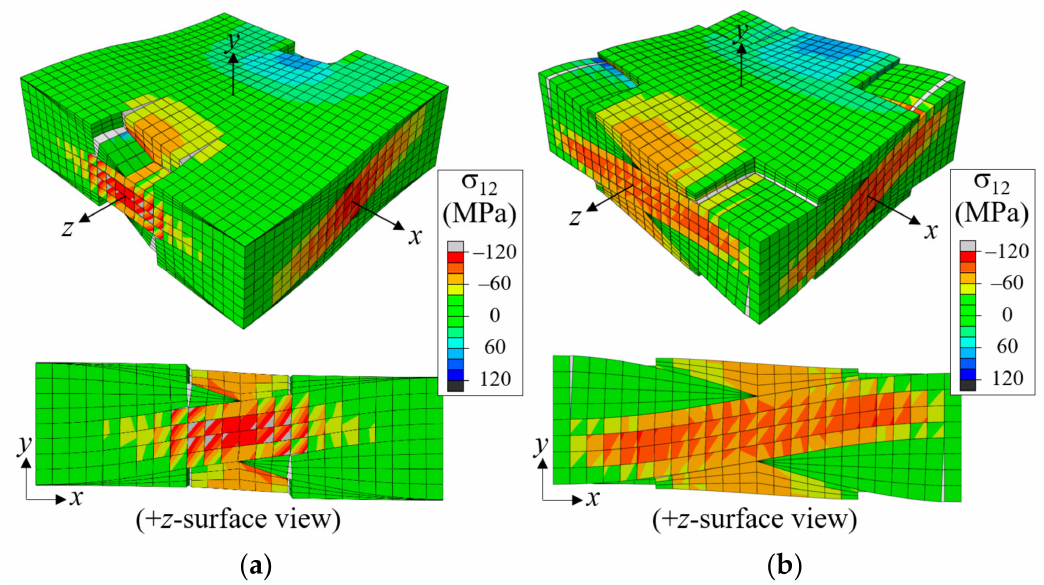
Figure 20. Comparison of σ 12 distribution for symmetric unit cells at ˆ ε xx = 0.0129; ( a ) MPV3; and ( b ) MPV4. (Deformation scale factors are 5 for iso-view and 2 for front z-surface